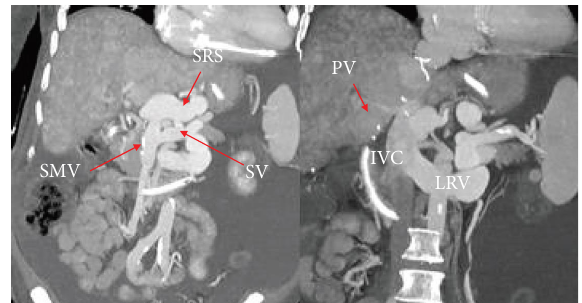
Figure 2: Contrast-enhanced CT showing both the large sple- norenal shunt (SRS) draining the superior mesenteric vein (SMV) and splenic vein (SV) into the left renal vein (LRV) and the small transplant portal vein (PV) anastomosed to the inferior vena cava